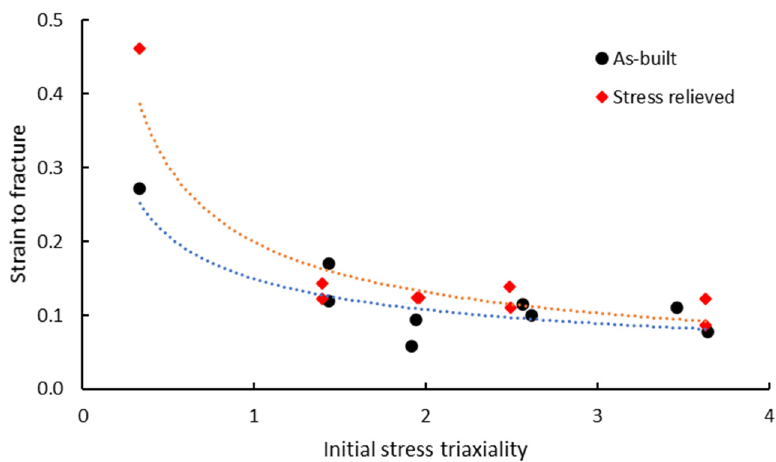
Figure 14. Equivalent strain to fracture as a function of initial stress triaxiality calculated based on experimental results.